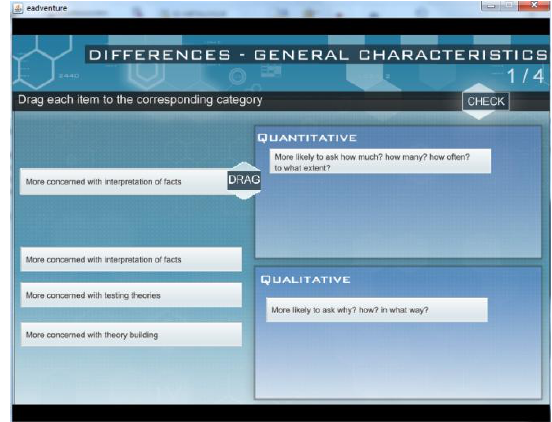
Figure 3. An example of differences between the qualitative and the quantitative approaches.